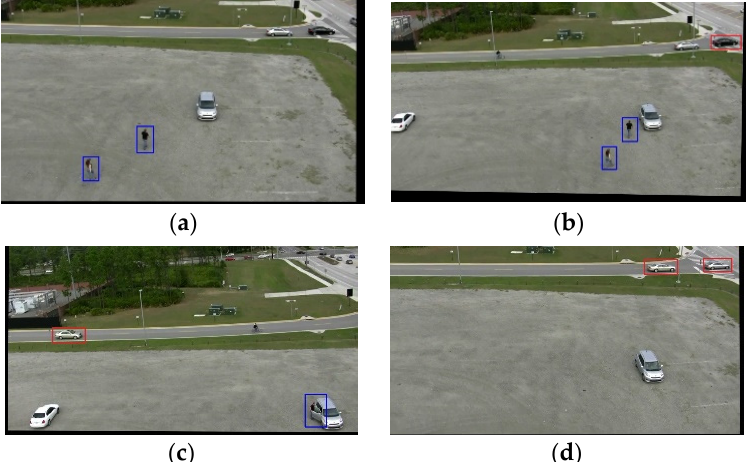
Figure 10. The result of moving object detection in Action1: ( a ) Frame 25, ( b ) frame 100, ( c ) frame 210, ( d ) frame 405.